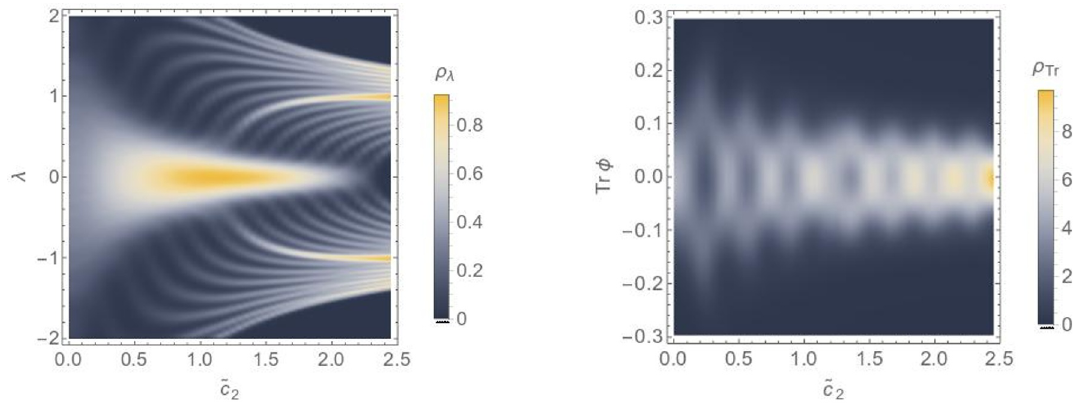
Figure 12 . Eigenvalue (left) and trace (right) distributions of the PP model with ∆ ν r = +1 curvature for N = 16 , c 4 = 0 . 01 , c r = 0 . 01 , ν 2 = ν 4 = 1 and varying values of e e correspond to larger values and peaks of distributions. Central bright region in the left plot, which dims and widens to the left, depicts the l phase which at around two cuts of the ↑↓ phase. Two thicker bright lines in the eigenvalue distribution plot are due to degenerate eigenvalues of the curvature matrix. Eigenvalues are expressed in units of √ and traces in units of N Tr Φ 2